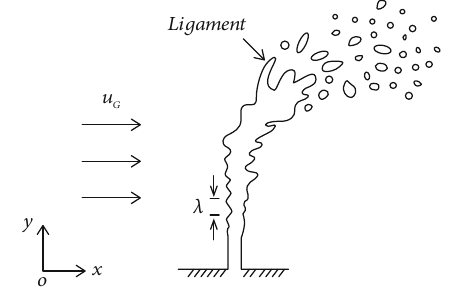
Figure 1: Schematic diagram of a liquid jet in transverse cross fl